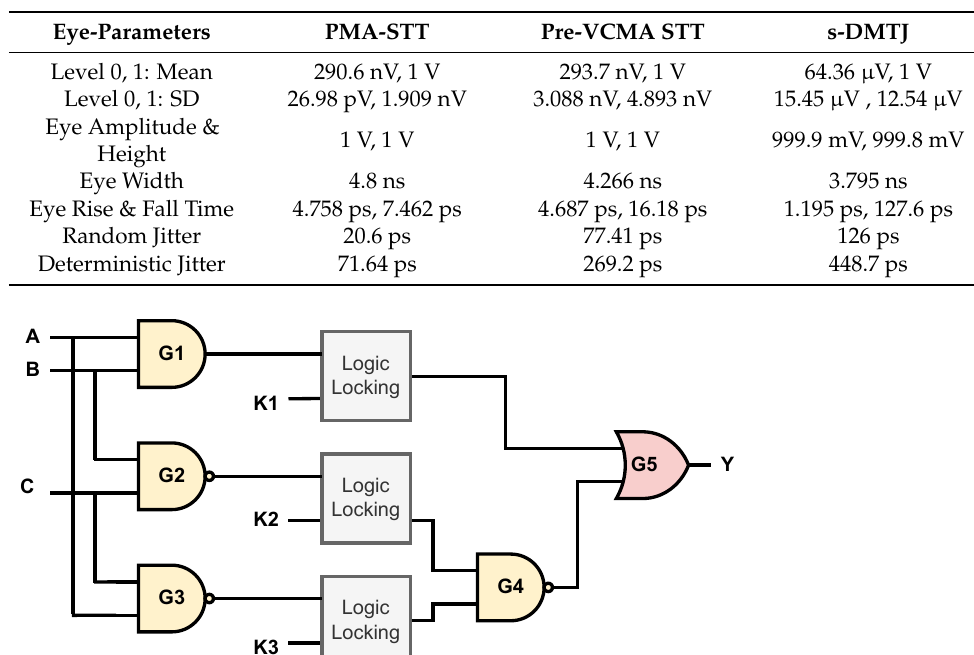
Table 2. Eye diagram test analysis for signal integrity for the selected MTJ devices for High speed digital circuits’ applications.